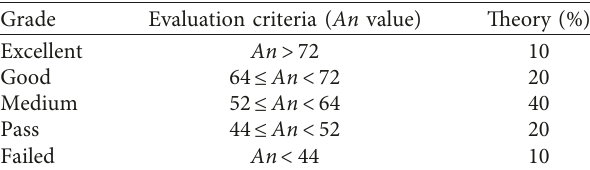
Table 4: Evaluation criteria for some indicators of track and field